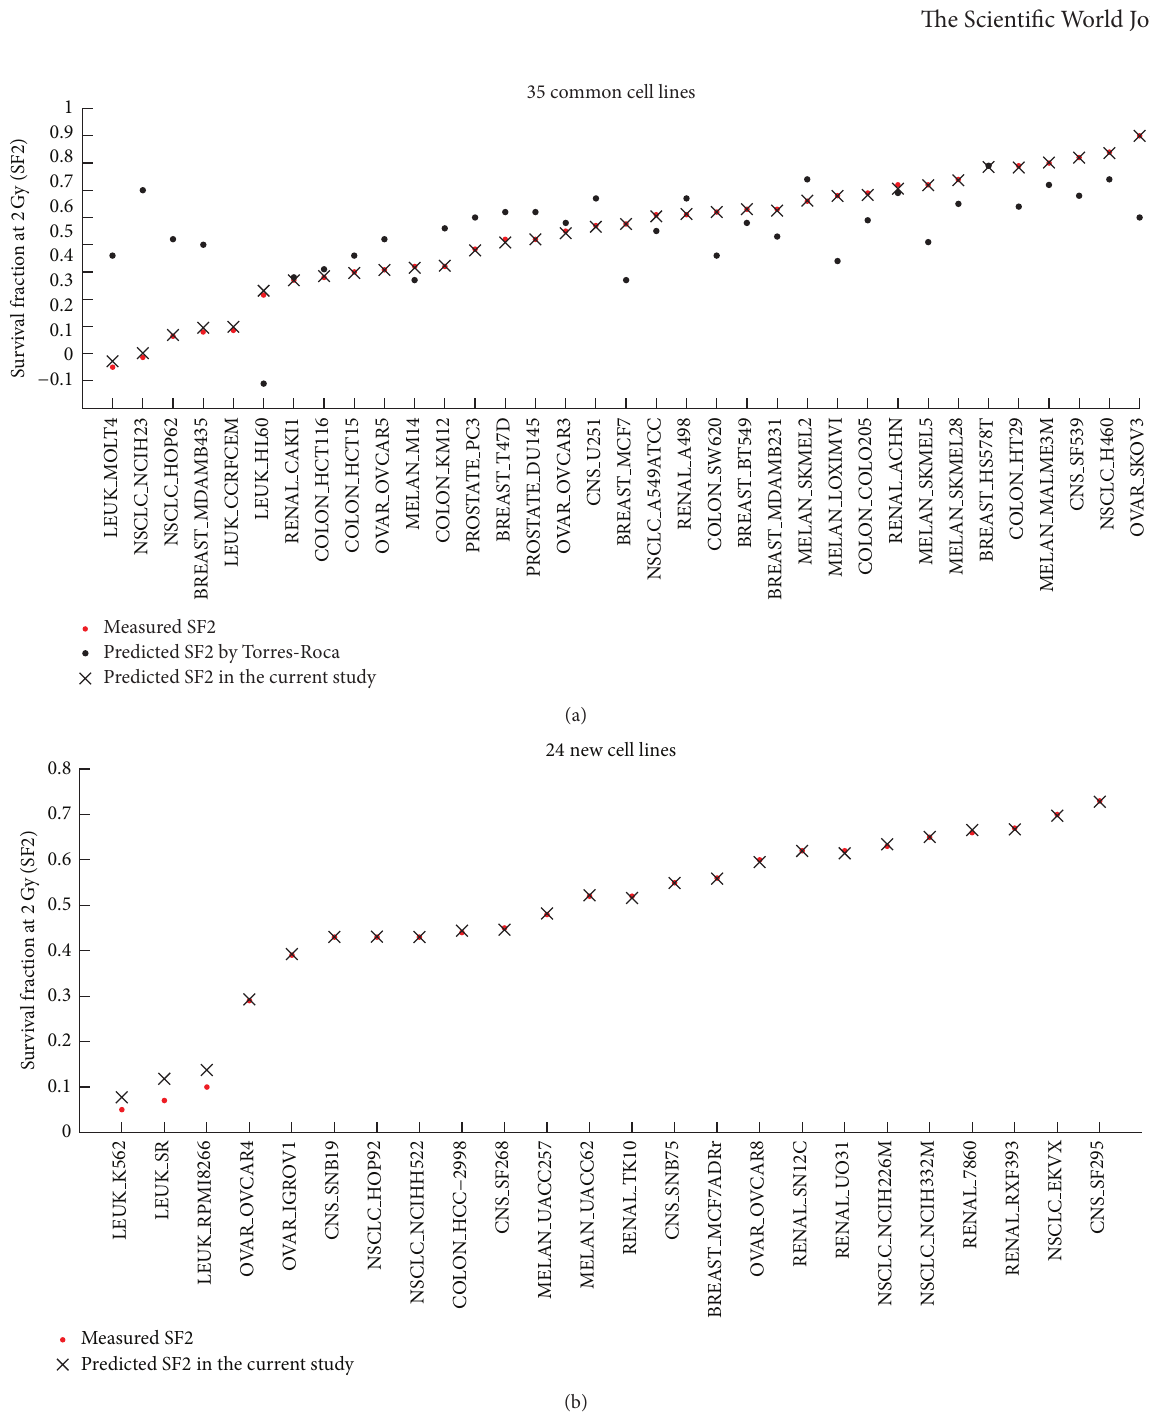
error of 0.048 was unique to the calculated error for the LEUK SR cell line. The RMSE of the prediction model was only 0.011, which is much smaller than the RMSE of 0.20 as reported by Torres-Roca et al. [12]. RMSE is a measure of the differences between the predicted and observed SF2 values. Smaller RMSE values indicate smaller difference between observed and predicted values. The accuracy of our model